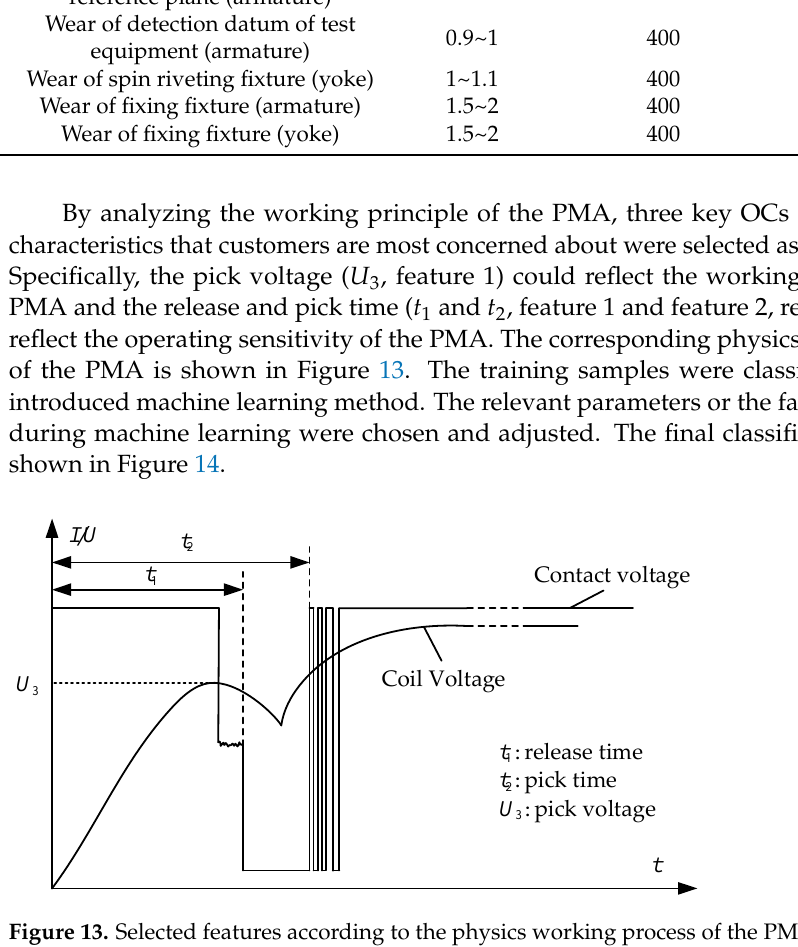
( b ) Figure 14. The diagnosis result: ( a ) final classification results; ( b ) the necessity for feature 3. Similarly, the diagnostic accuracy of the model could be calculated from the classifi- cation results of the testing samples: 92